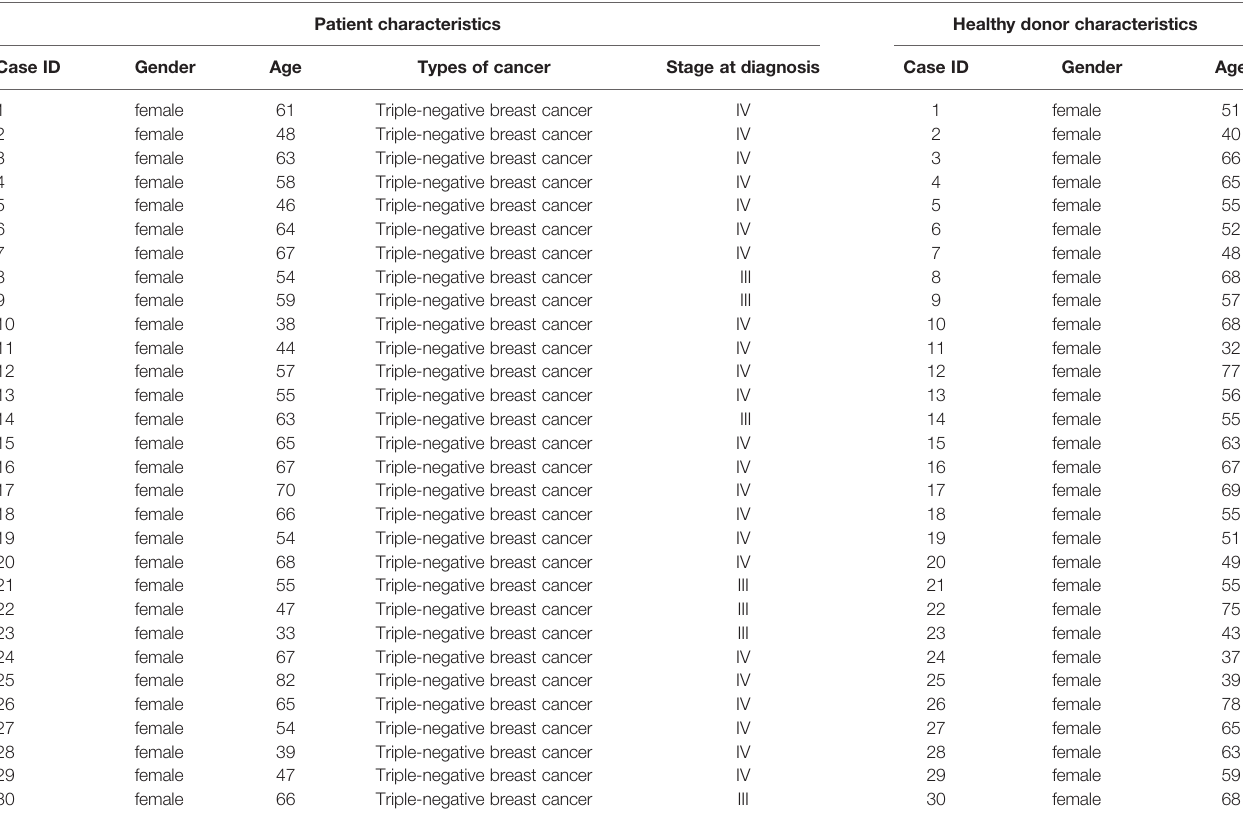
TABLE 1 | Information of TNBC patients and healthy